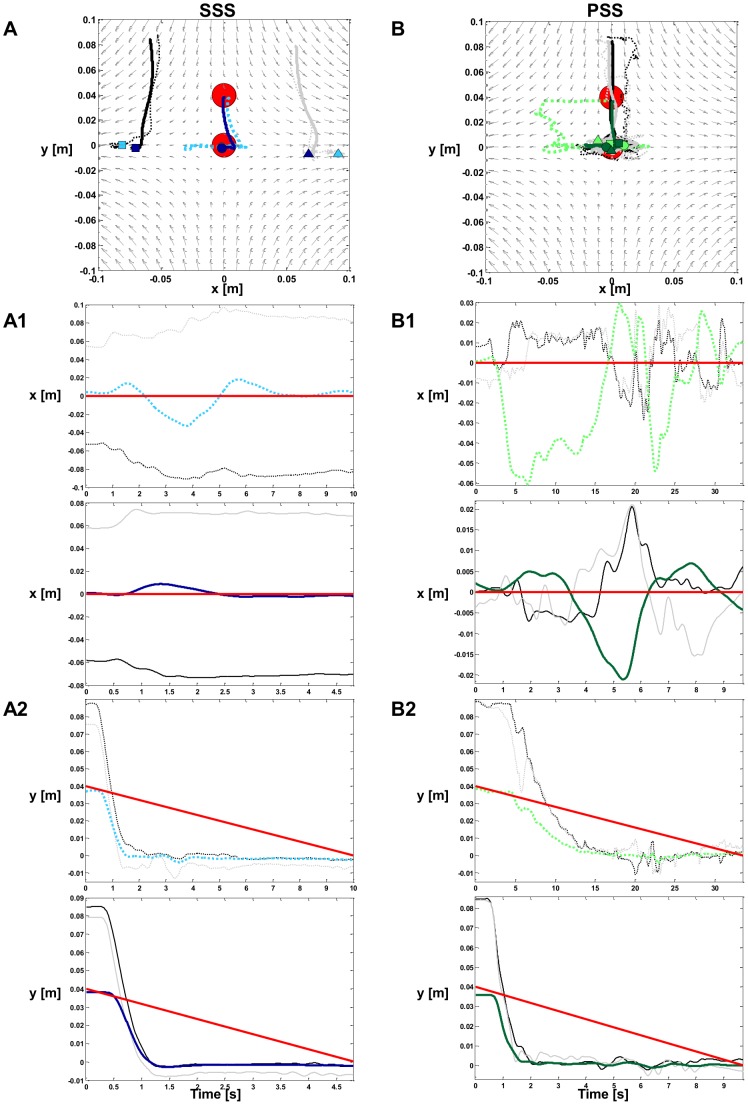
Example of performance in task A (reaching) by subject S1 in the early and final phase of training.Panels A, A1, A2 refer to the SSS and panels B, B1, B2 to the PSS. In particular for the SSS: hand trajectories (black and gray lines), virtual mass trajectory (blue lines), final positions of the left hand (blue square), right hand (blue triangle) and virtual mass (blue circle). For the PSS: hand trajectories (black and gray lines), virtual mass trajectory (green lines), final positions of the left hand (green square), right hand (green triangle) and virtual mass (green circle). In both cases the tool-tip is initially at equilibrium in the forward target and the task is to move it to the central target. The panels show the evolution of the tool-tip and the two hands in different manners: in the workspace (panels A and B) and as functions of time (panels A1, B1 for the x-component and A2, B2 for the y-component). The curves related to the early phase are dotted and the curves related to the final phase of training are continuous. The red lines in panels A1, B1, A2, B2 represent the ideal evolutions of the tool-tip.